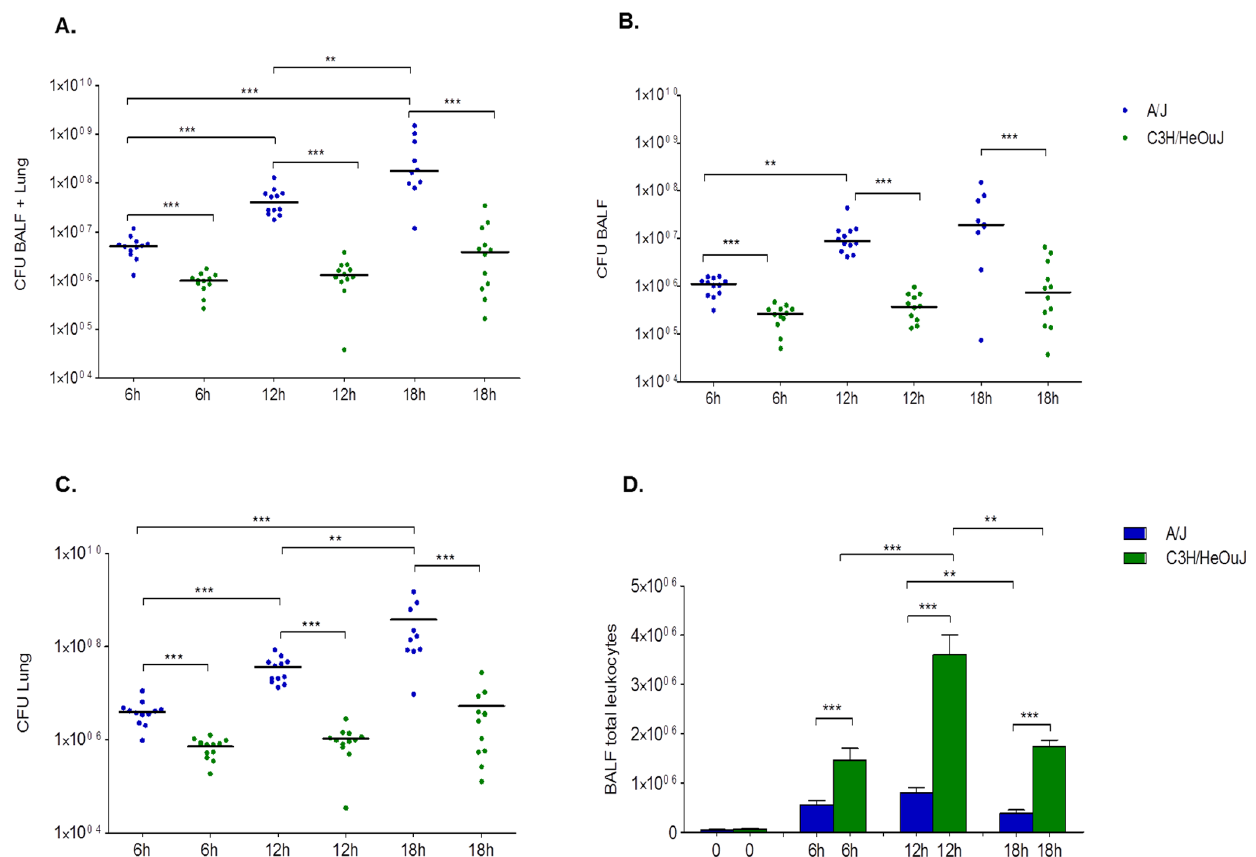
Figure 2. P.aeruginosa load and leukocytes recruitment in BALF and lung of A/J and C3H/HeOuJ mice. A/J (n=12, for each time) and C3H/HeOuJ (n=12, for each time) mice were challenged with 5 6 10 6 CFU of AA2 clinical stain and analysed during a time course post-infection. Bacterial loads in the BALF + Lung ( A ), BALF ( B ) and lung ( C ) and were counted at 6, 12 and 18 hours in surviving mice. Dots represent CFUs in individual mice and horizontal lines represent median values reported in log scale. Total leukocytes were analyzed in BALF of P. aeruginosa infected mice ( D ). Bars represent median values and the error bars indicate the standard error of the mean (SEM). Blue is referred to A/J and green to C3H/ HeOuJ. The data are pooled from two independent experiments. Statistical significance by Mann-Whitney U test is indicated: **p , 0.01, ***p , 0.001, ****p , 0.0001.